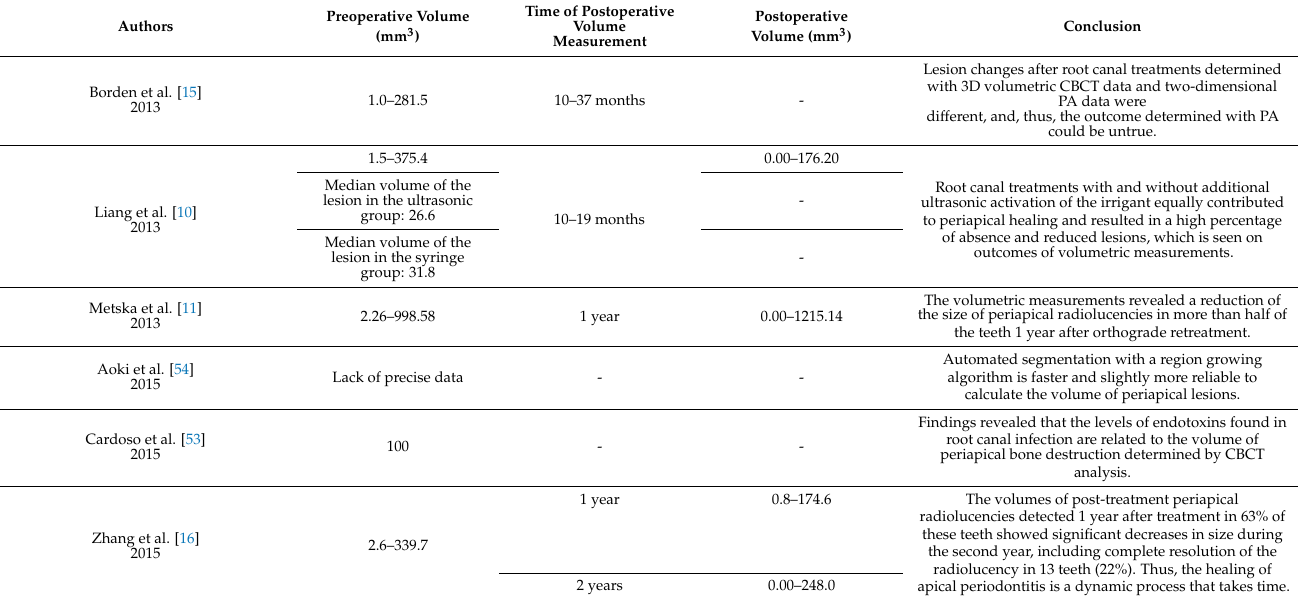
Table 4. Summarized results of included